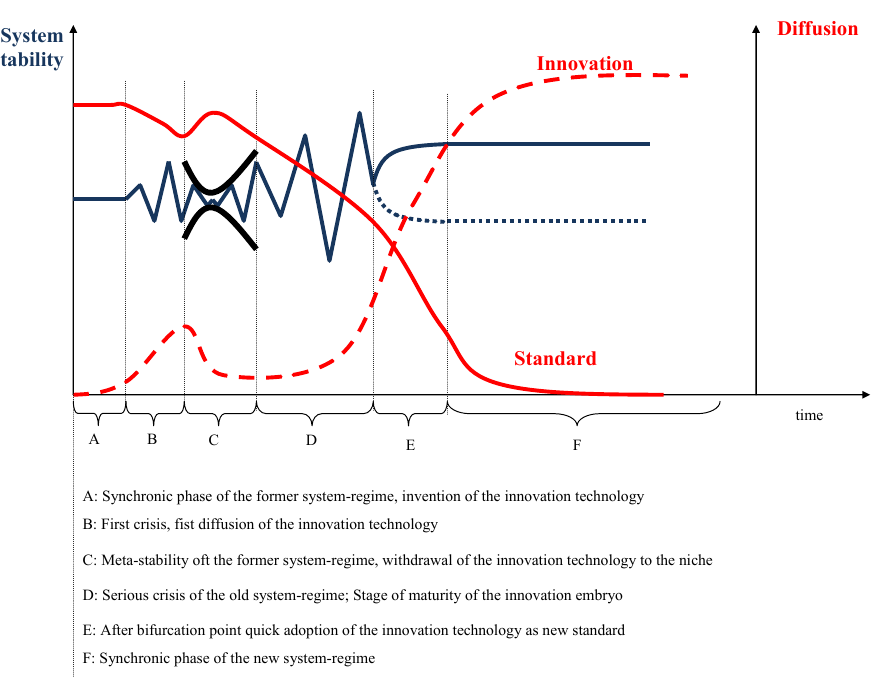
Figure 5. Change of the system regimes, following on [22]. Figure 5 indicates that the adoption process is hardly ever a straightforward